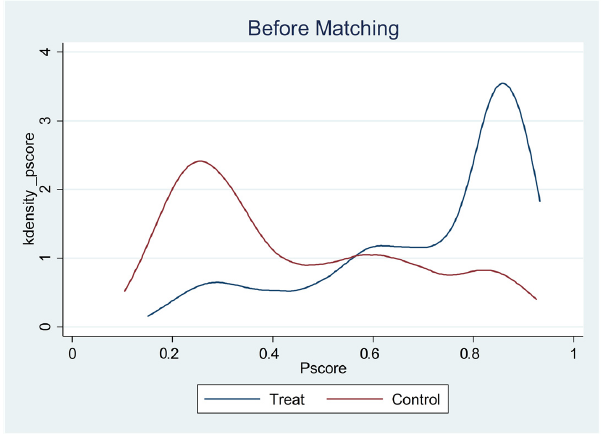
Figure 1. Distribution of propensity scores for the pre-matching treatment and control groups.